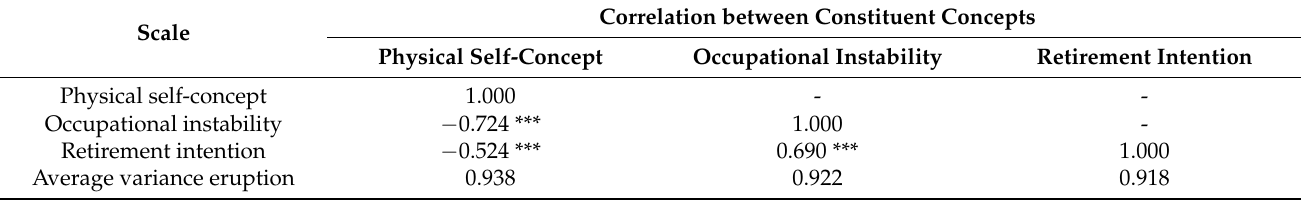
Table 5. Correlation between constituent